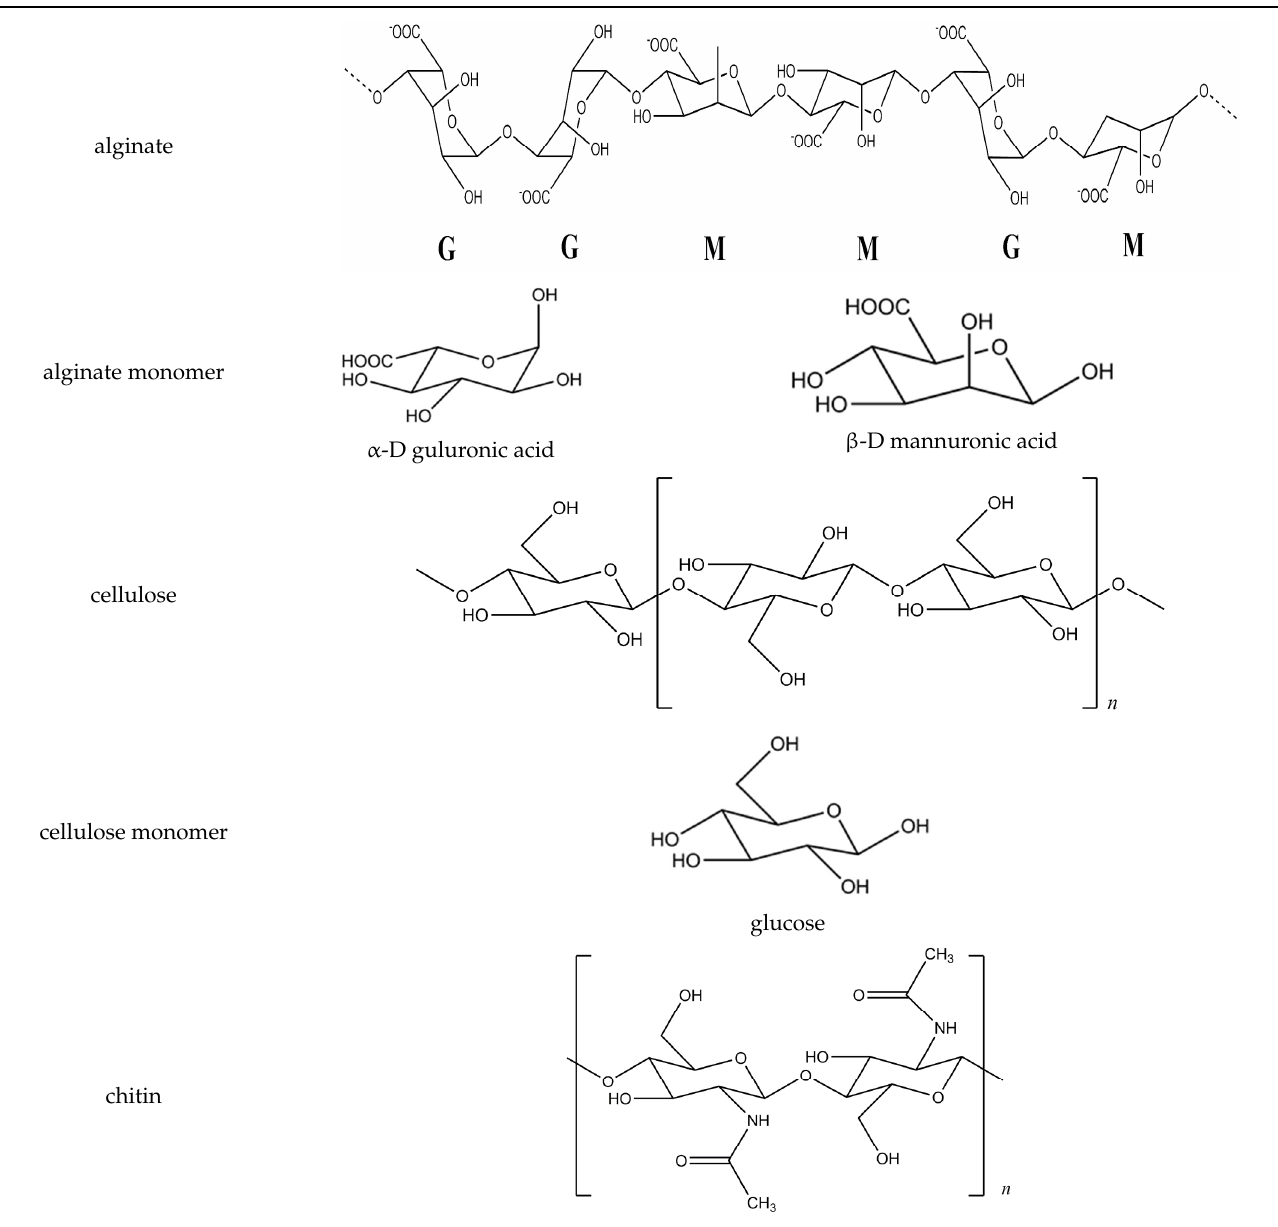
Table 2. Main biopolymers and their chemical structures [62].